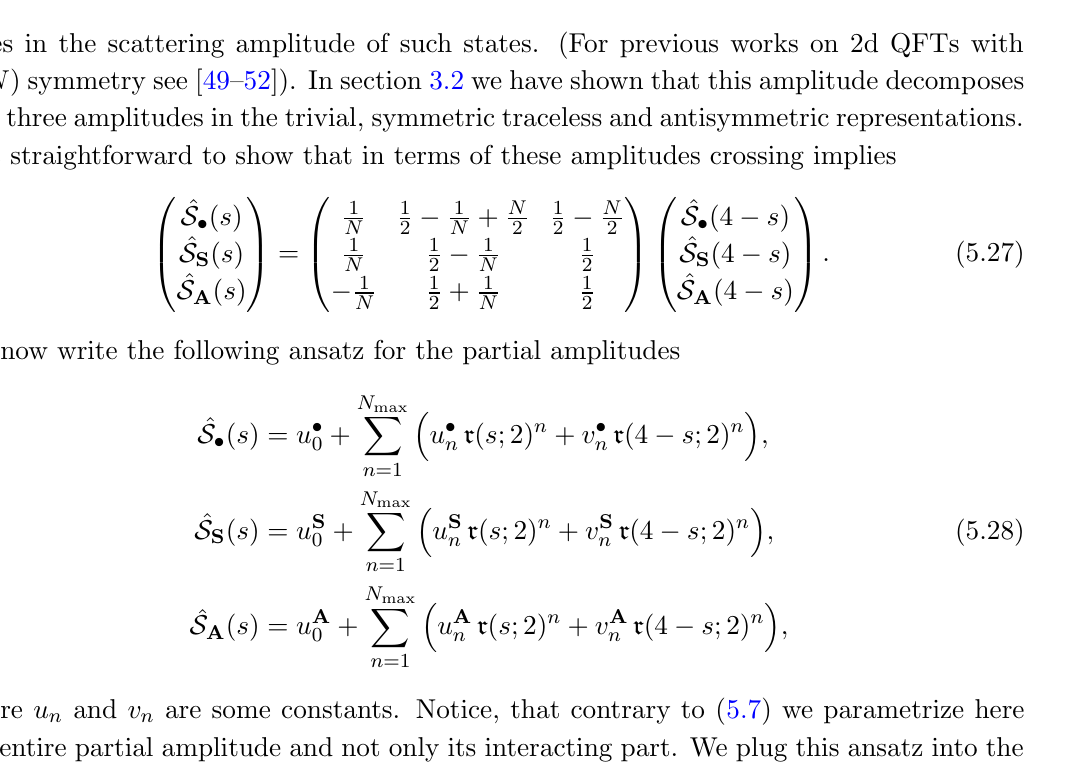
Figure 8 . The real part, the imaginary part and the absolute value of the partial amplitude of the scattering of the lightest asymptotic states in the E 8 model. The plot is constructed with N max =